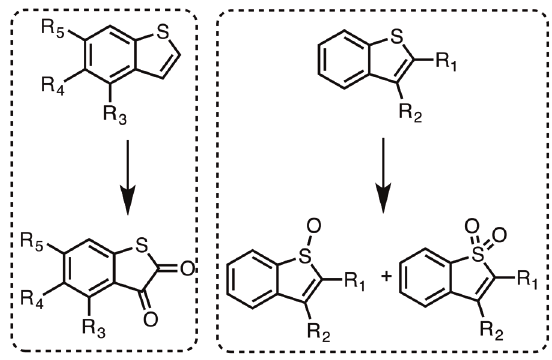
Figure 22 - Oxidation of benzothiophene derivatives by Pseudomonas sp. BT1.